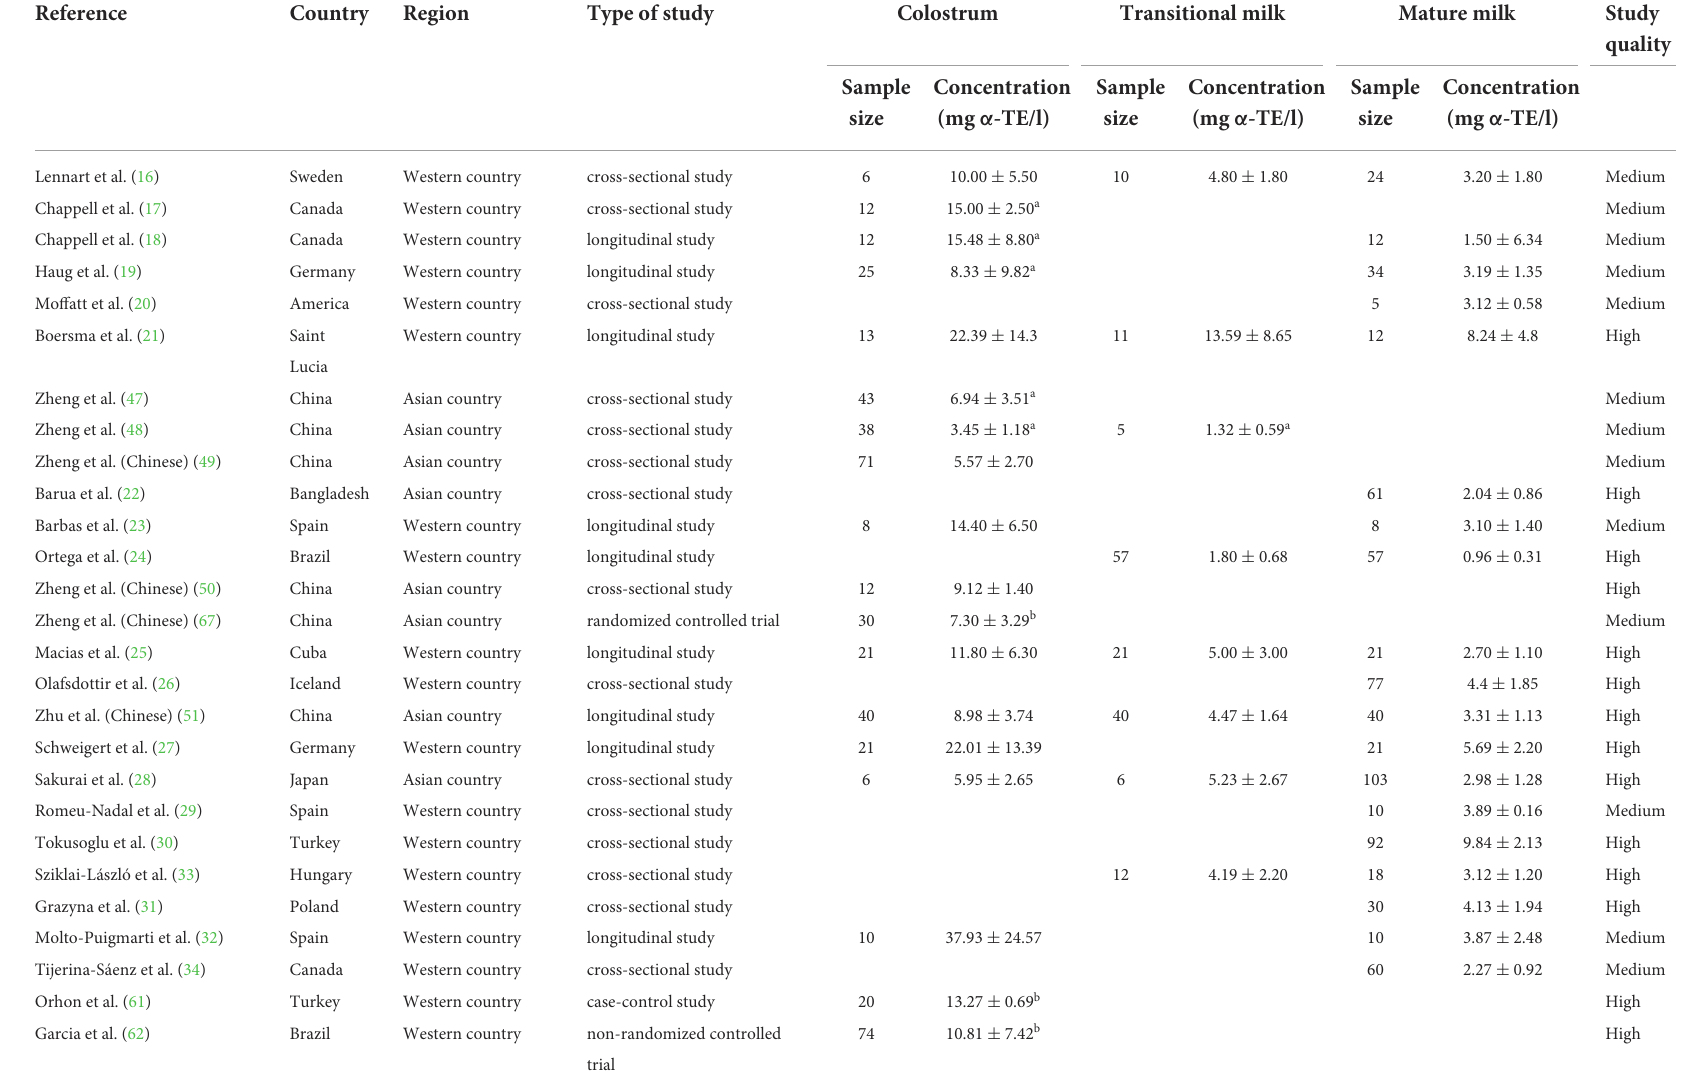
TABLE 2 Characteristics of included studies for the